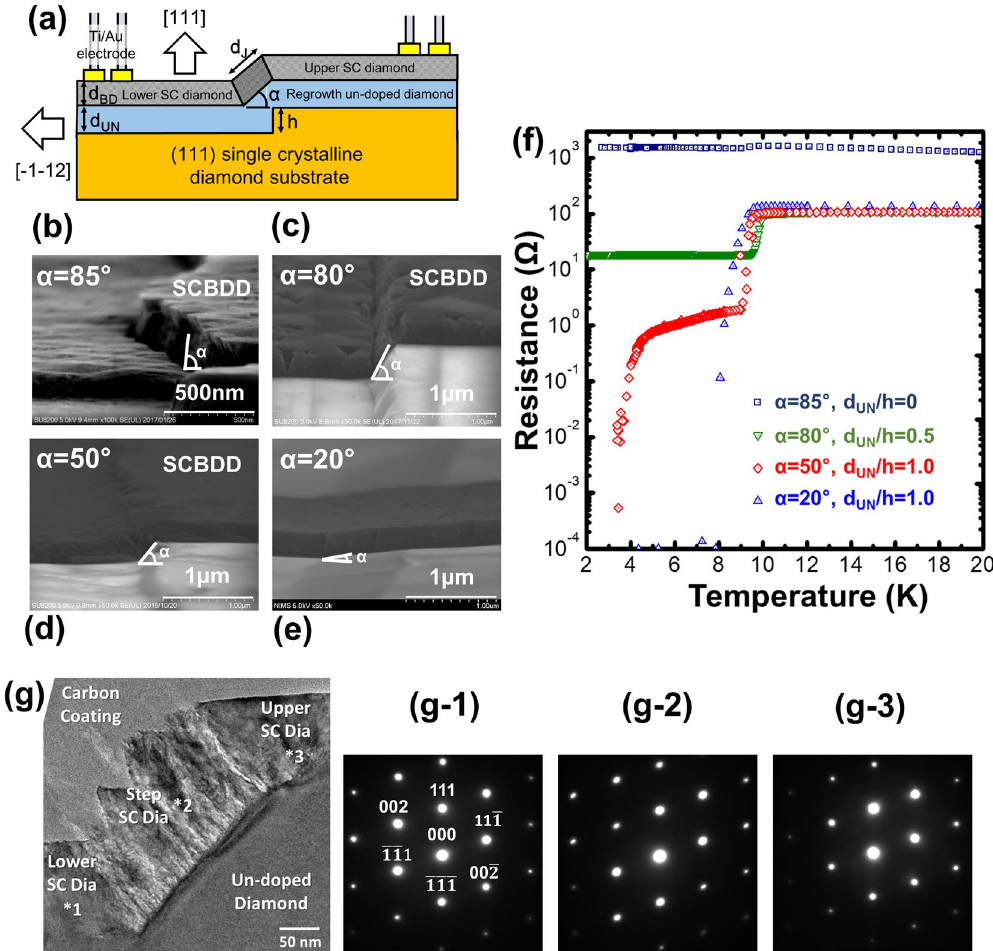
Figure 2. ( a ) Schematic diagram of cross-section of regrowth-induced step edge structure. ( b – e ) SEM images of the step edge structures with step angles α of 85°, 80°, 50°, and 20°. ( f ) Temperature dependence of the resistance of the superconducting diamond step edge structure for α of 85°, 80°, 50°, and 20°. ( g ) Cross- sectional TEM images of the fabricated regrowth-induced step edge structure. (g-1)–(g-3) are the diffraction patterns from the lower, step, and upper superconducting layers, respectively. The asterisks in ( g ) indicate the locations where the diffraction patterns were obtained.